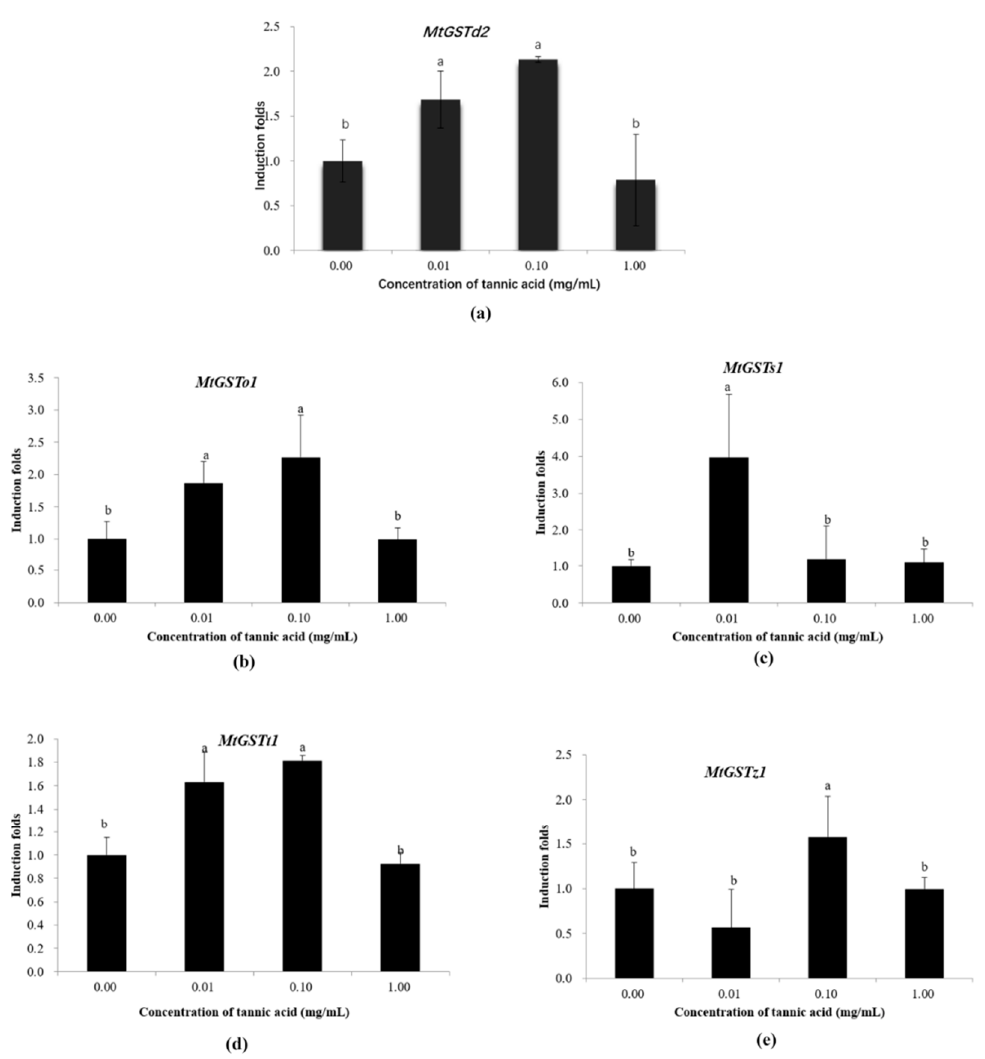
Figure 4. The e ff ect of tannic acid on promoter activities. ( a ) MtGSTd2 ; ( b ) MtGSTo1 ; ( c ) MtGSTs1 ; ( d ) MtGSTt1 ; ( e ) MtGSTz1 Figure 4. The effect of tannic acid on promoter activities.